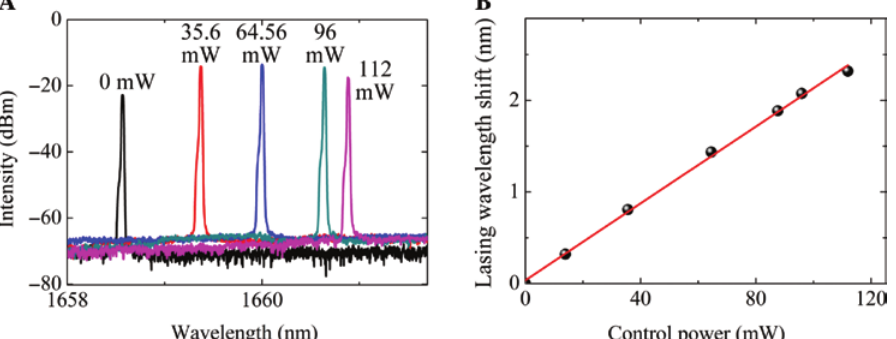
Figure 9: Tuning performance of the Raman microlaser. (A) Raman lasing spectra for different control powers. (B) Raman lasing wavelength shift as a function of the control power.